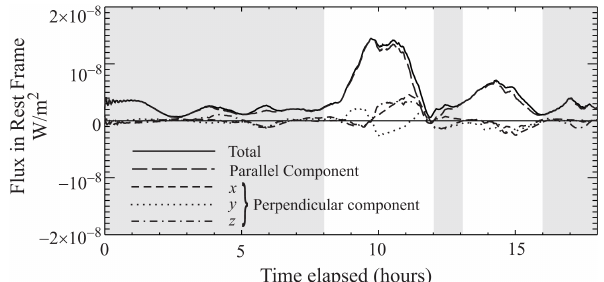
Figure 3. Magnitude of wave flux vector in rest frame of solar wind. Time is measured from 01:31 on 7 June 2000. The unshaded por- tions of the diagram indicate the peaks in wave energy